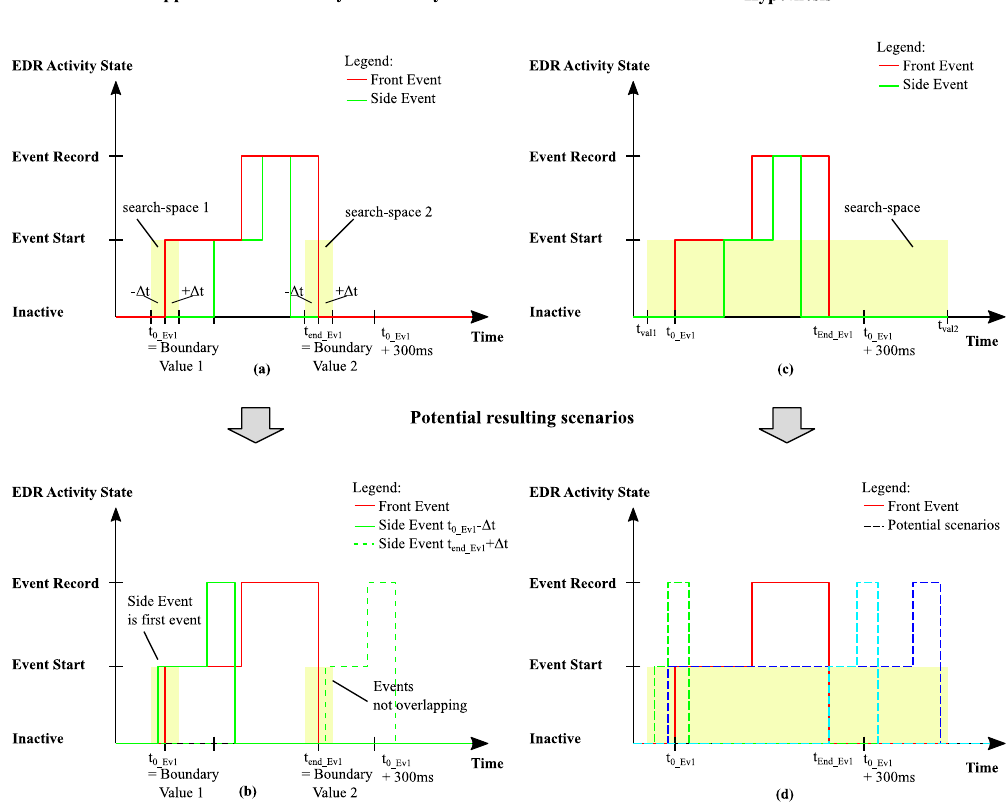
Figure 9. Comparison of a standard test method and the hypothesis for the test method under development. ( a ) identification of a boundary-value analysis; ( b ) resulting scenario after boundary-value analysis; ( c ) extension of the search-space as part of the working hypothesis; ( d ) resulting scenario after application of the hypothesis.